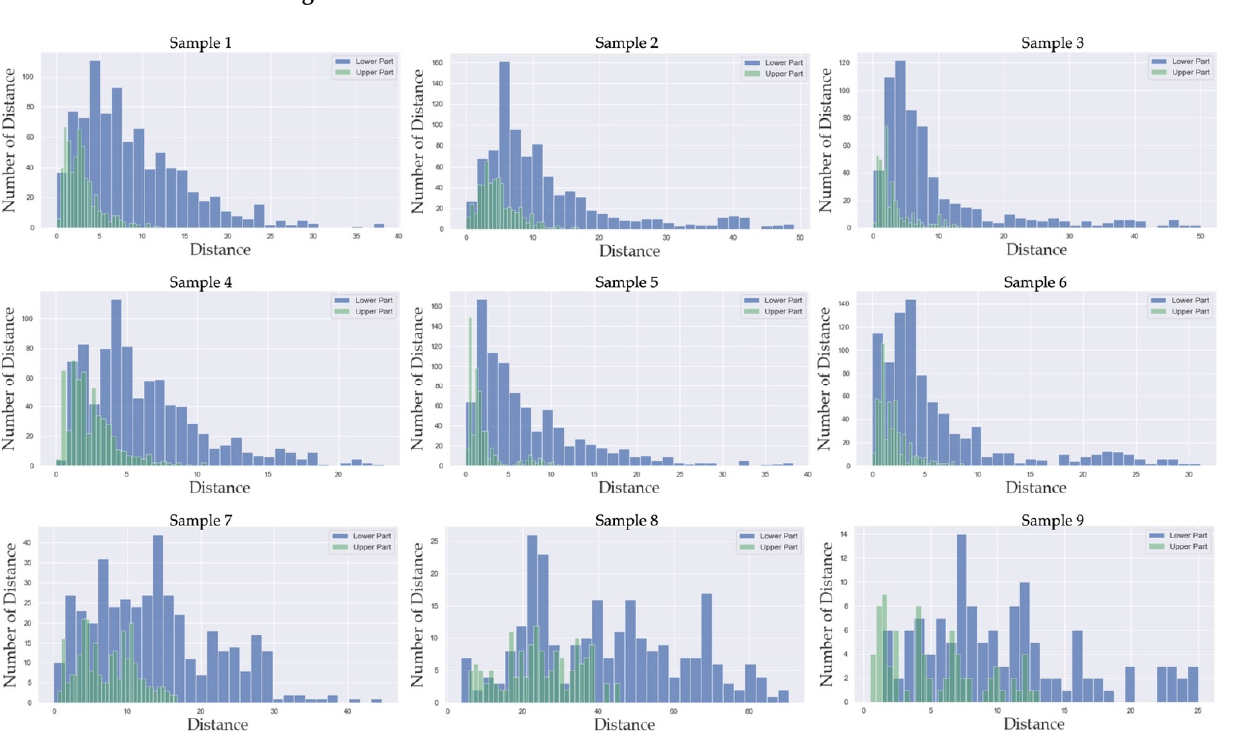
Figure 3. Histograms of the distance between landmarks across all emotions from nine CK+ samples.